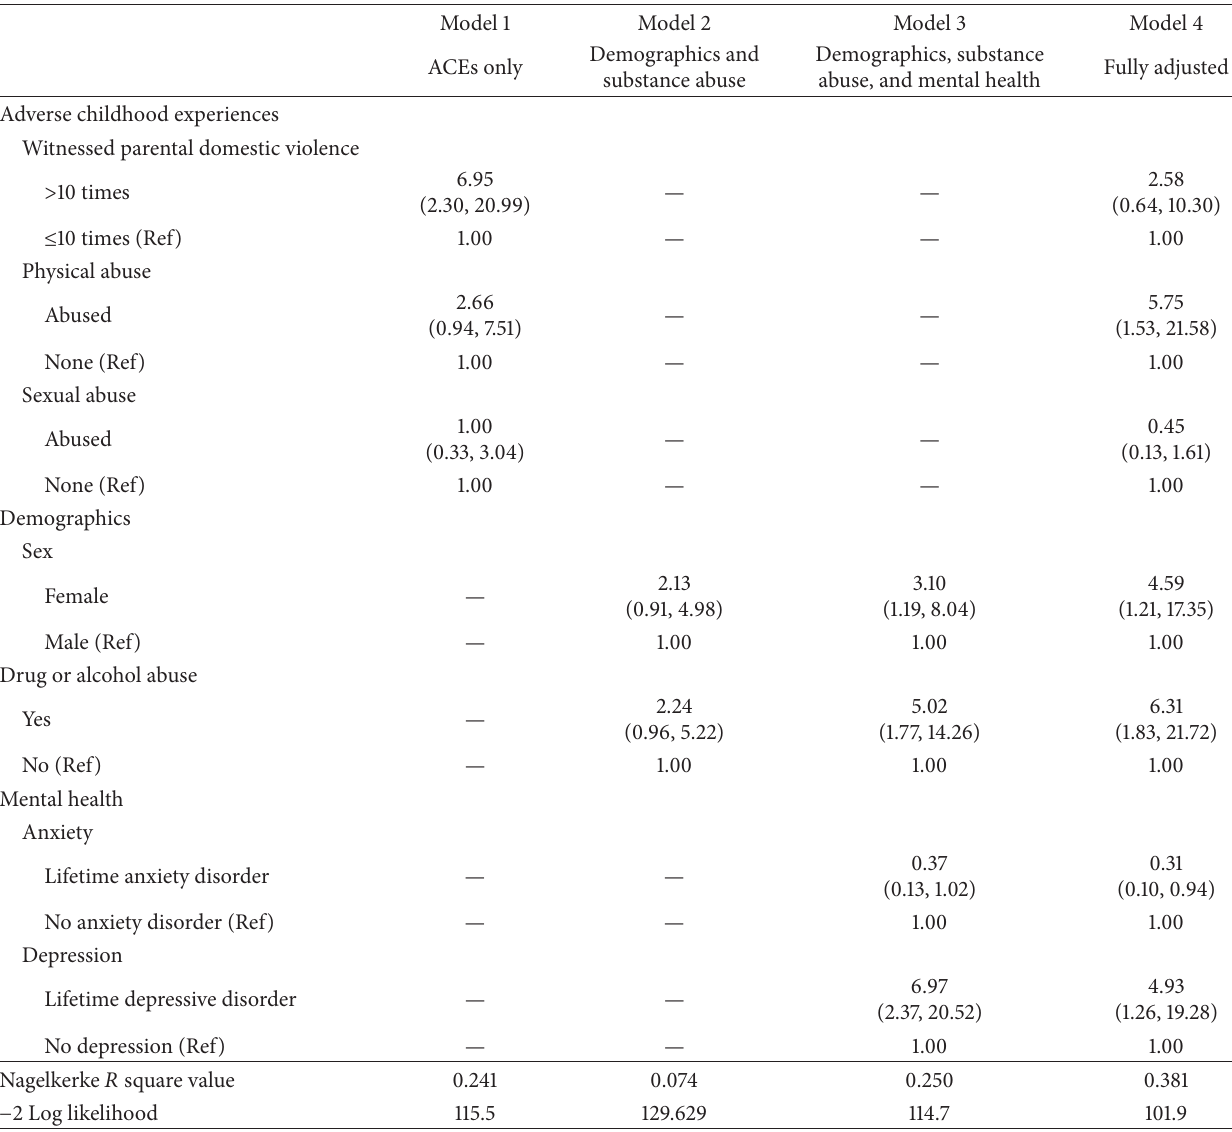
Table 2: Odds ratios and 95% confidence interval of lifetime suicide attempt among those with schizophrenia from a representative community-based sample ( 𝑛 = 101